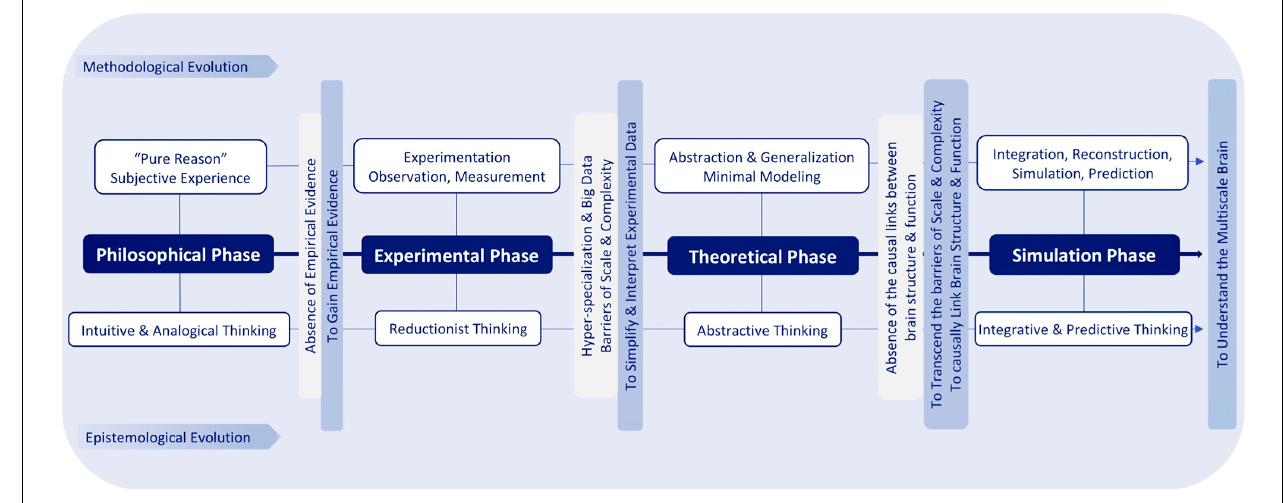
FIGURE 2 | Epistemological and methodological evolution of brain